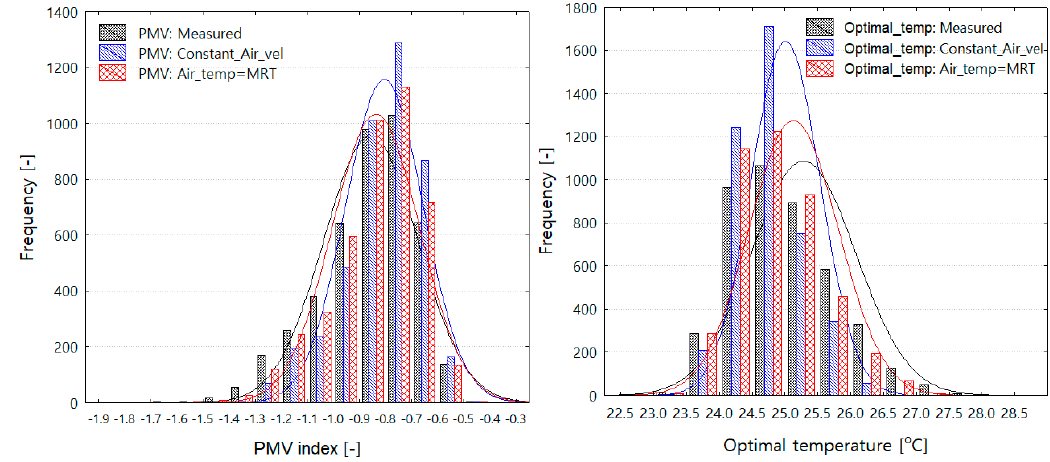
Figure 11. PMV frequency distributions in measurement and two scenarios.